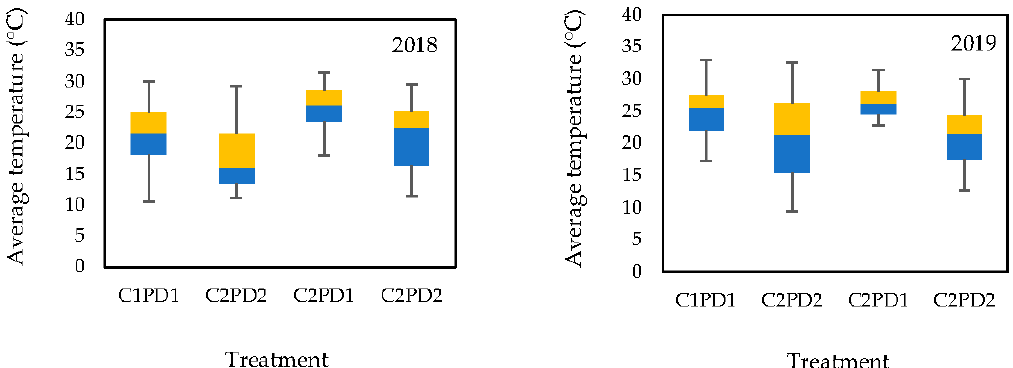
Figure 2. Variability of average daily temperatures ( ° C) during the reproductive stage of maize for conventional and late planting dates in 2018 and 2019: the upper and lower hinges of the box indicate the 75th percentile and 25th percentile of the data set, respectively. The line in the box indicates the median value of the data, and the upper and lower whiskers represent the maximum and minimum of the data, respectively. PD1, planting date 21 June; PD2, planting date 22 July; C1, KSC704; C2, KSC260.